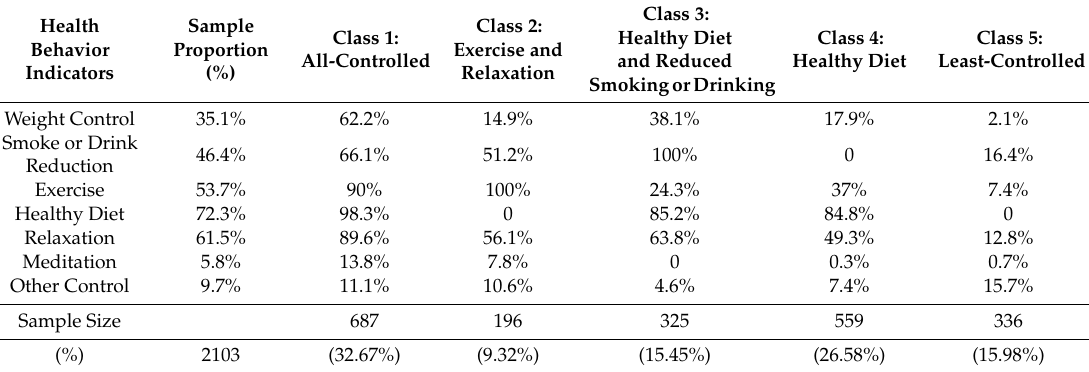
Table 4. Distribution of health behavior indictors and conditional probabilities per